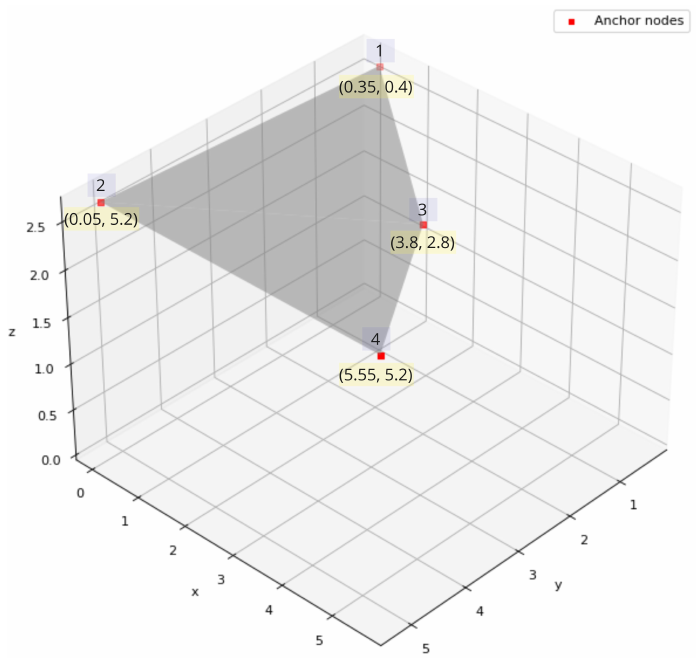
Figure 2. Locations of anchor nodes inside the room.